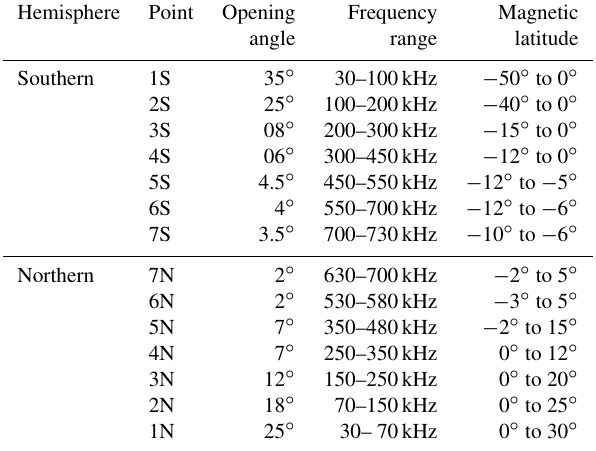
Table 1. Observational parameters of the main parts of the spectral patterns as indicated in Fig. 6. Hemisphere Point Opening Frequency Magnetic angle range